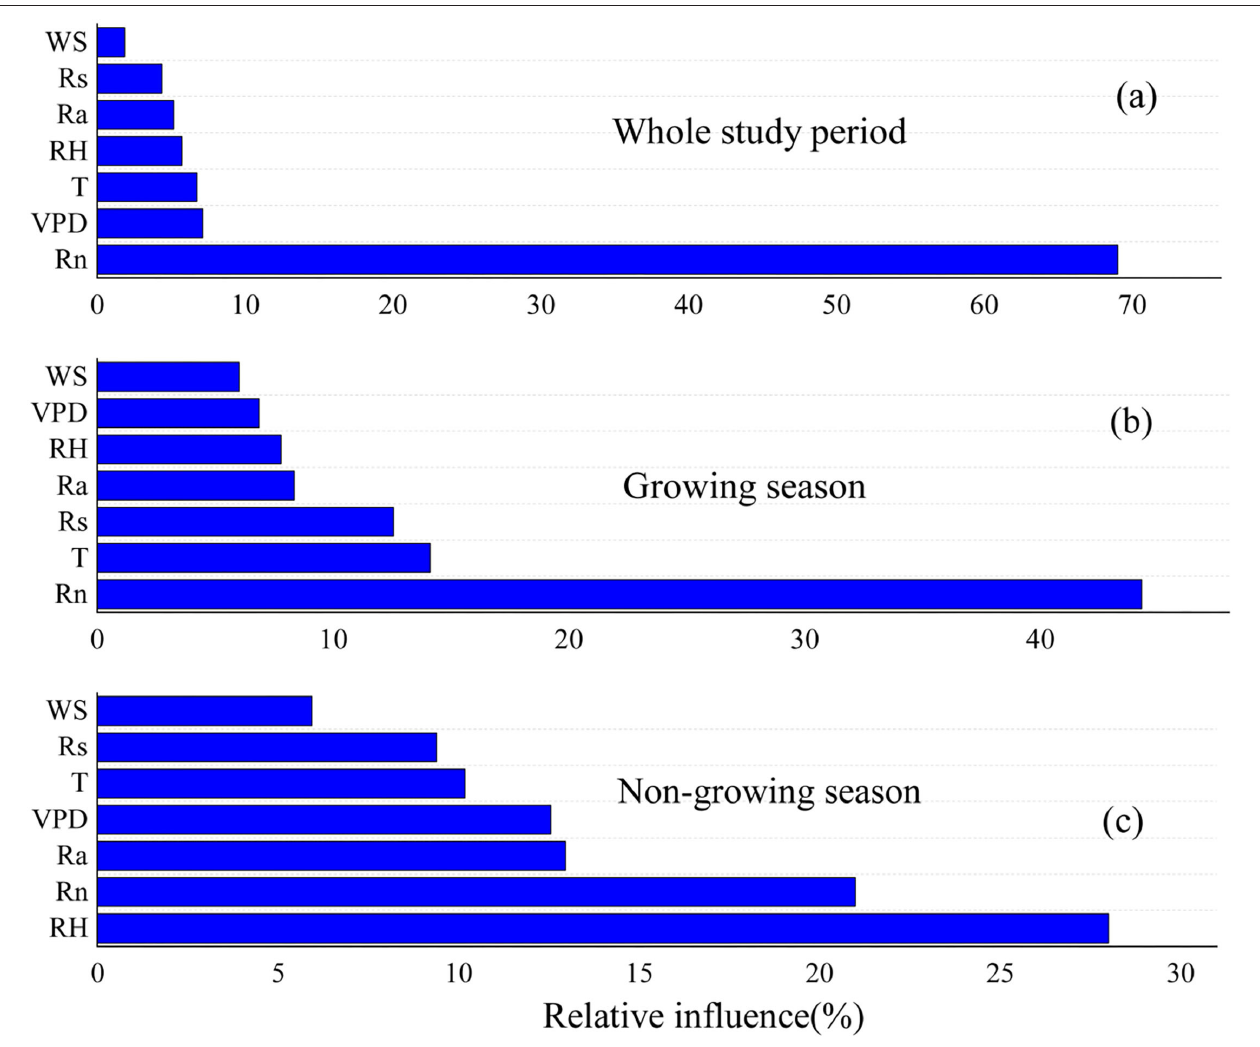
FIGURE 8 | The relative influence of meteorological factors on ET a during whole study period (a) , growing season (b) , and non-growing season (c) . WS, wind speed; TD, the difference value between maximum air temperature and the minimum air temperature; G , soil heat flux; R a , extraterrestrial solar radiation; R s , total radiation; VPD, vapor pressure deficit; RH, relatively humid; T , mean air temperature; R n , net